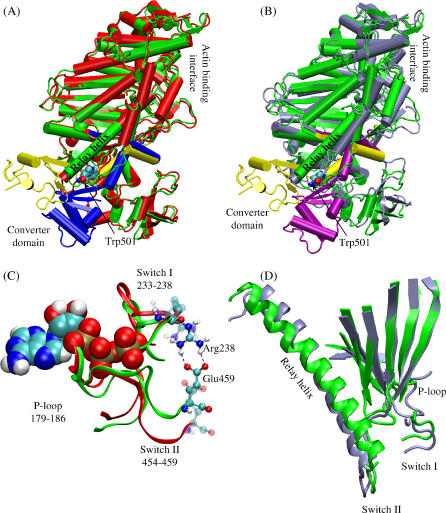
Structural Differences between Conformations of the Dictyostelium discoideum Myosin Motor Domain(A) The difference between the post-rigor (1FMW [29]) and pre-powerstroke (1VOM [30]) states. The structures are aligned based on backbone atoms in the first 650 residues; red and blue correspond to 1FMW, green and yellow correspond to 1VOM. Trp501 is shown in the van der Waals form.(B) The difference between the pre-powerstroke (1VOM [30]), and near-rigor (1Q5G [37]) states. The structures are aligned based on backbone atoms in the first 650 residues; green and yellow correspond to the 1VOM state, slate blue and purple correspond to the 1Q5G state.(C) Superposition of the active site region in 1FMW and 1VOM (same color coding as in (A); the nucleotide is shown in the van der Waals form).(D) Superposition of the central β sheet in 1VOM and 1Q5G (same color coding as in (B); the two structures are superimposed according to the 6th and 7th β strands). The Switch II in the two states are in very similar positions. The distal end of the β sheet (strand 1–4) twists. Note that this leads to a displacement of the P-loop.